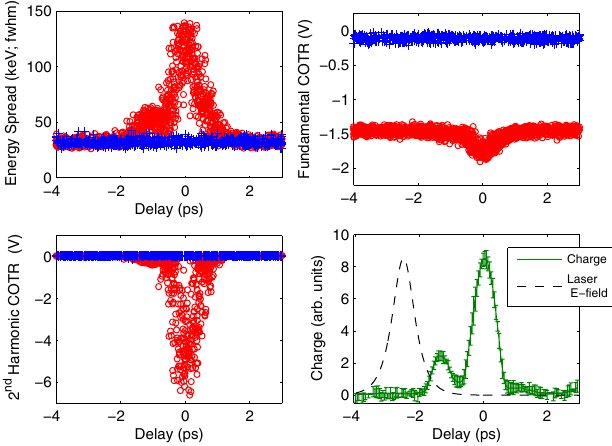
FIG. 2. (Color) Example data run of the IFEL microbunching experiment containing 2130 events. Top left is the electron energy spread as a function of delay with laser-on events in red (circles), laser-off in blue (crosses). Also shown are the COTR raw signals at the fundamental (top right) and second harmonic (bottom left). The bottom right figure shows the current profile calculated by deconvolving the laser pulse from the cross-correlation